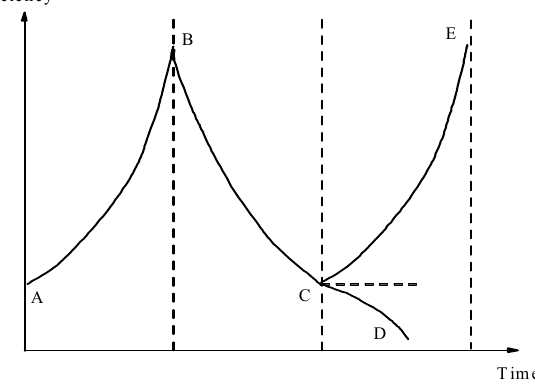
Figure 2. The entropy change of reclamation projects and their adjacent marine ecosystems with time changes [30].